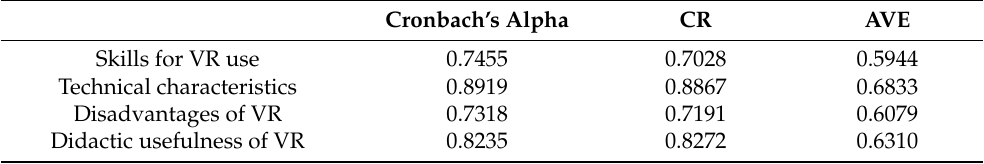
Table 1. Cronbach’s alpha, composite reliability (CR), and average variance extracted (AVE) parameters.